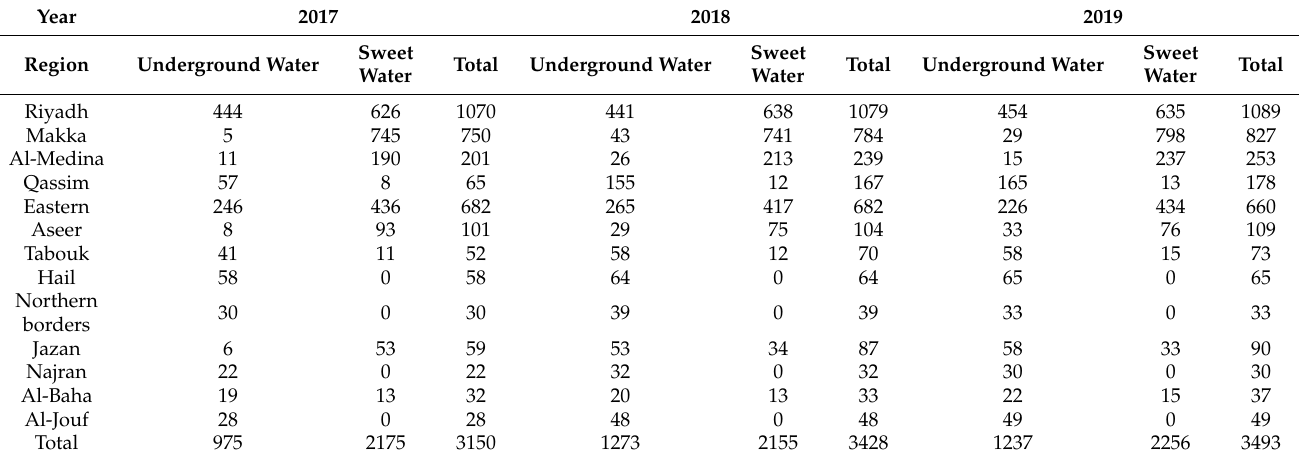
Table 1. Water resources quantity in the eastern